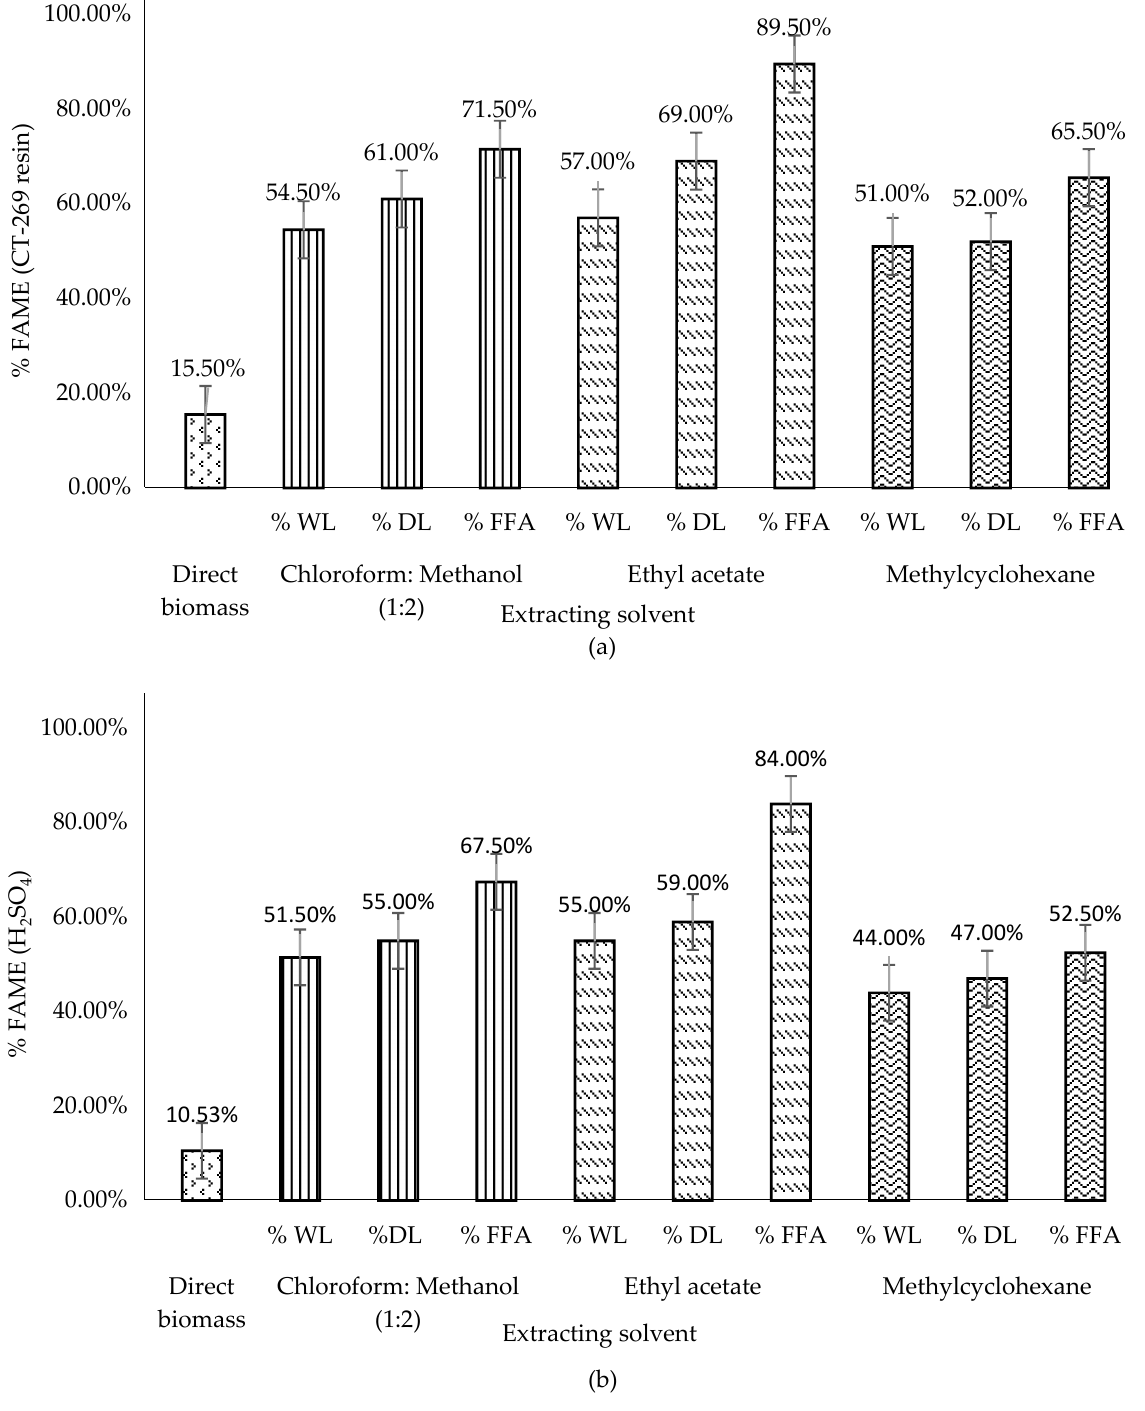
Figure 6. Fatty acid methyl esters weight content of Scenedesmus sp. with the three best extracting solvents using different direct biomass, lipids from wet biomass (WL), lipids from dry biomass (DL) and lipids from FFA (FFA) with two catalysts ( a ) CT-269 resin and ( b ) sulfuric acid (H 2 SO 4 ). The values are presented as means of triplicate measures with their corresponding standard deviation ( ± SD) .